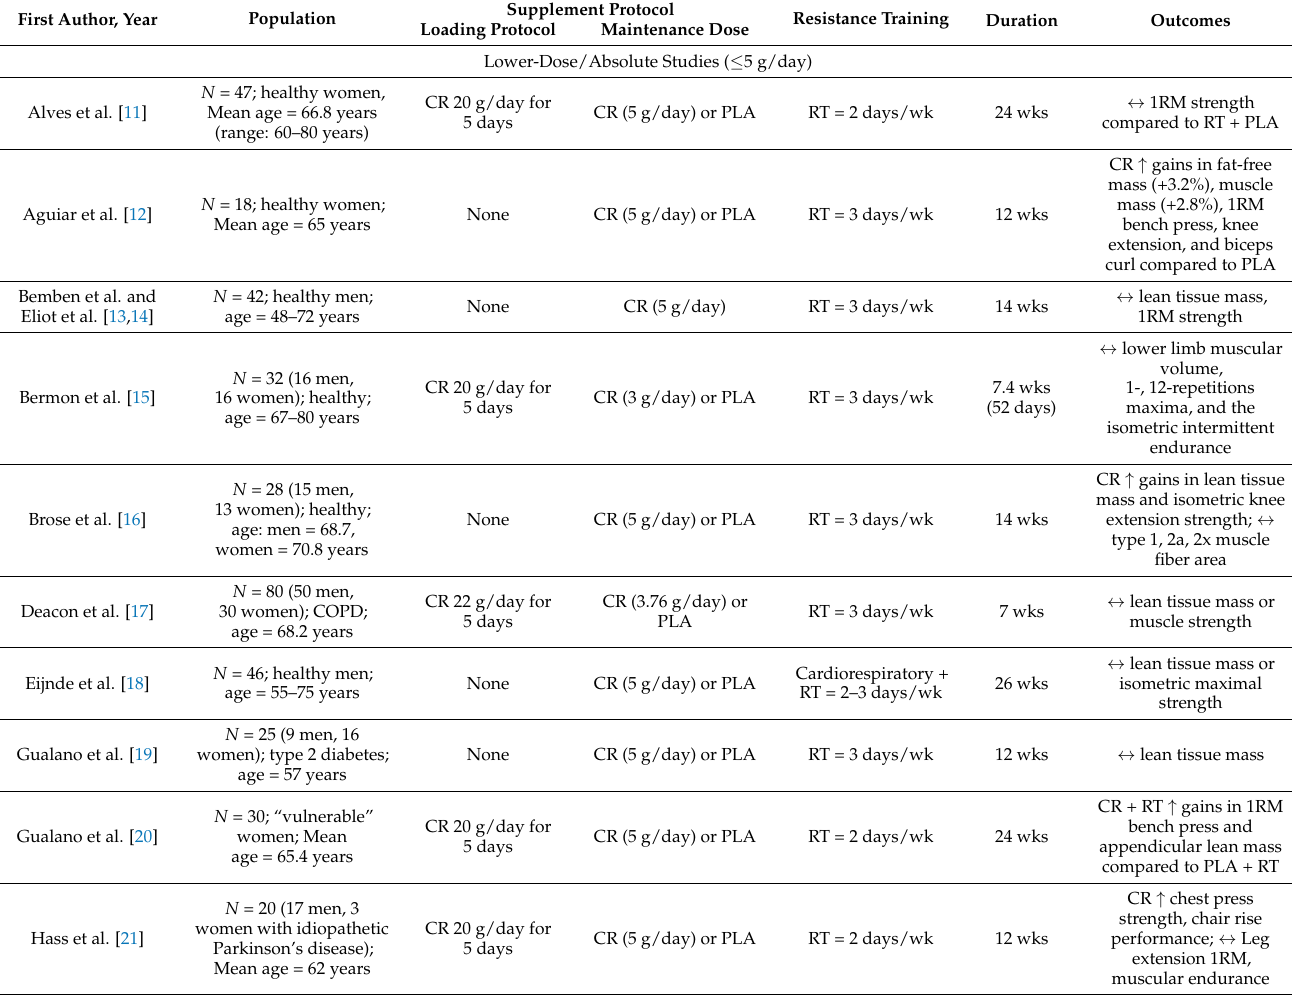
Table 1. Study characteristics, dosing strategy, and outcomes of research examining the influence of creatine in older adults with a resistance training